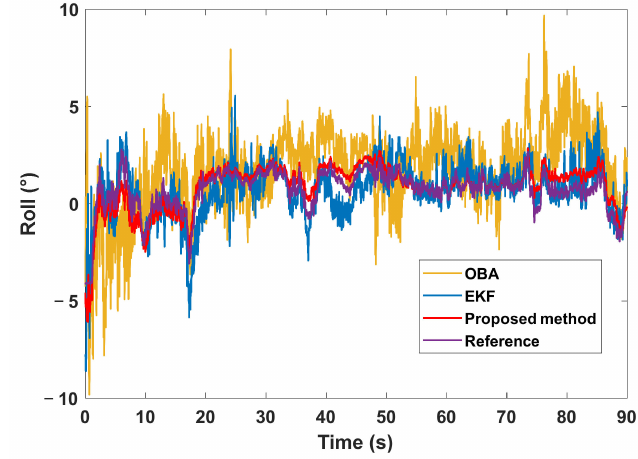
Figure 14. Real time roll angle estimation curves of three different IFA methods.